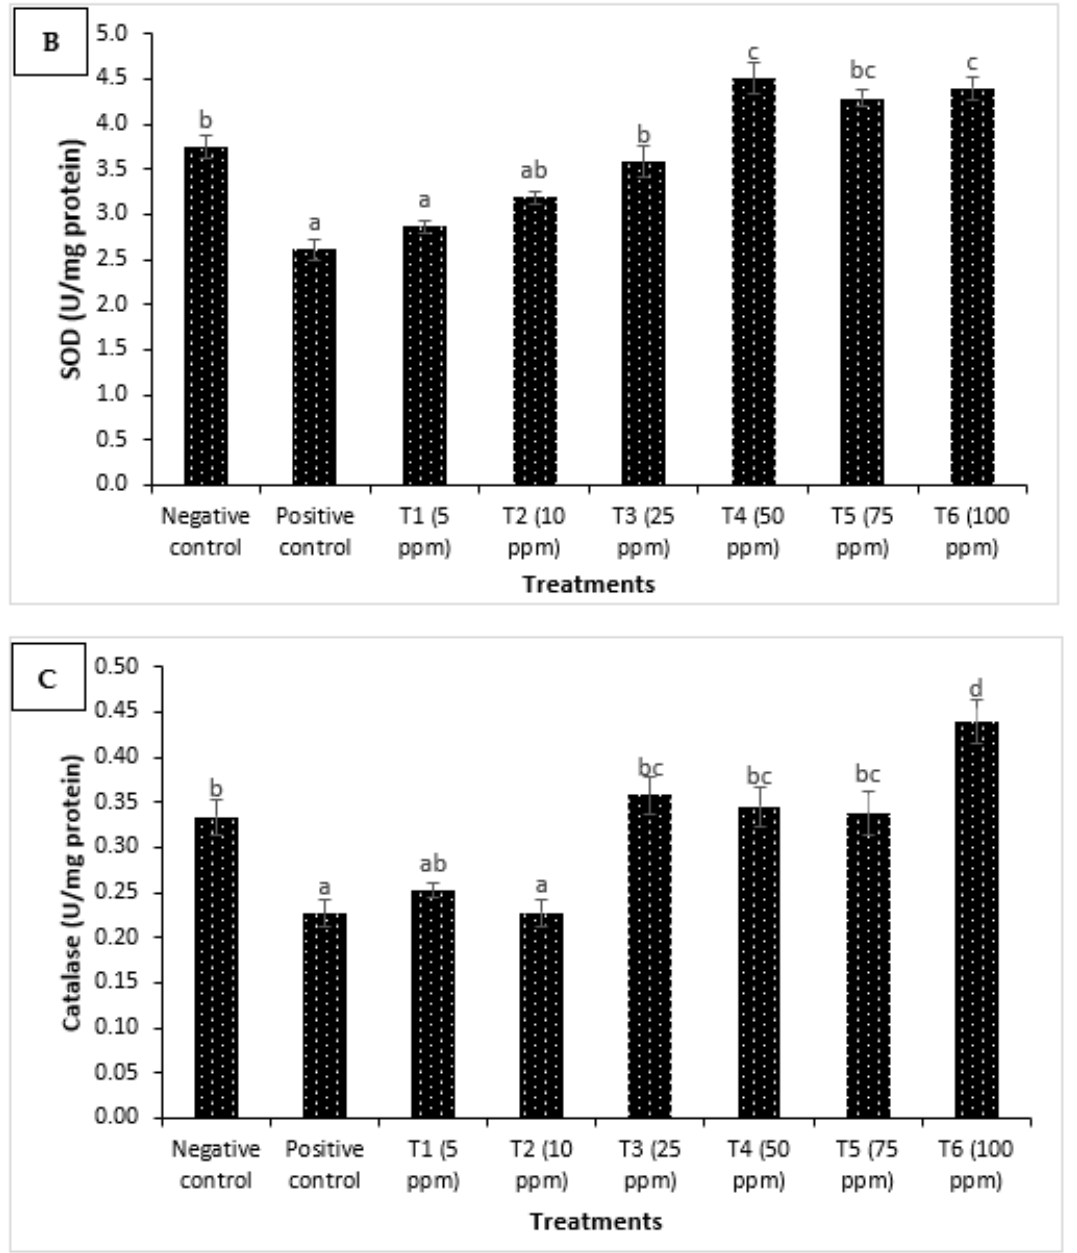
Figure 6. Eclipta alba leaf extract reduces stress and enhances antioxidant defense of H. fossilis fingerlings against A. invadans . The serum samples of H. fossilis fingerlings were collected from 8 treatment groups. The fingerlings in T1–T6 groups were treated with leaf extract at the indicated doses. Non-pretreated larvae that were either challenged with A. invadans (positive control) or unchallenged (negative control) served as controls. ( A ) cortisol concentration (ng/mL); ( B ) superoxide dismutase (SOD) activity (U/mg protein); ( C ) catalase (CAT) activity (U/mg protein). Error bars represent the standard error of five replicates; different letters indicate significant differences ( p < 0.05).